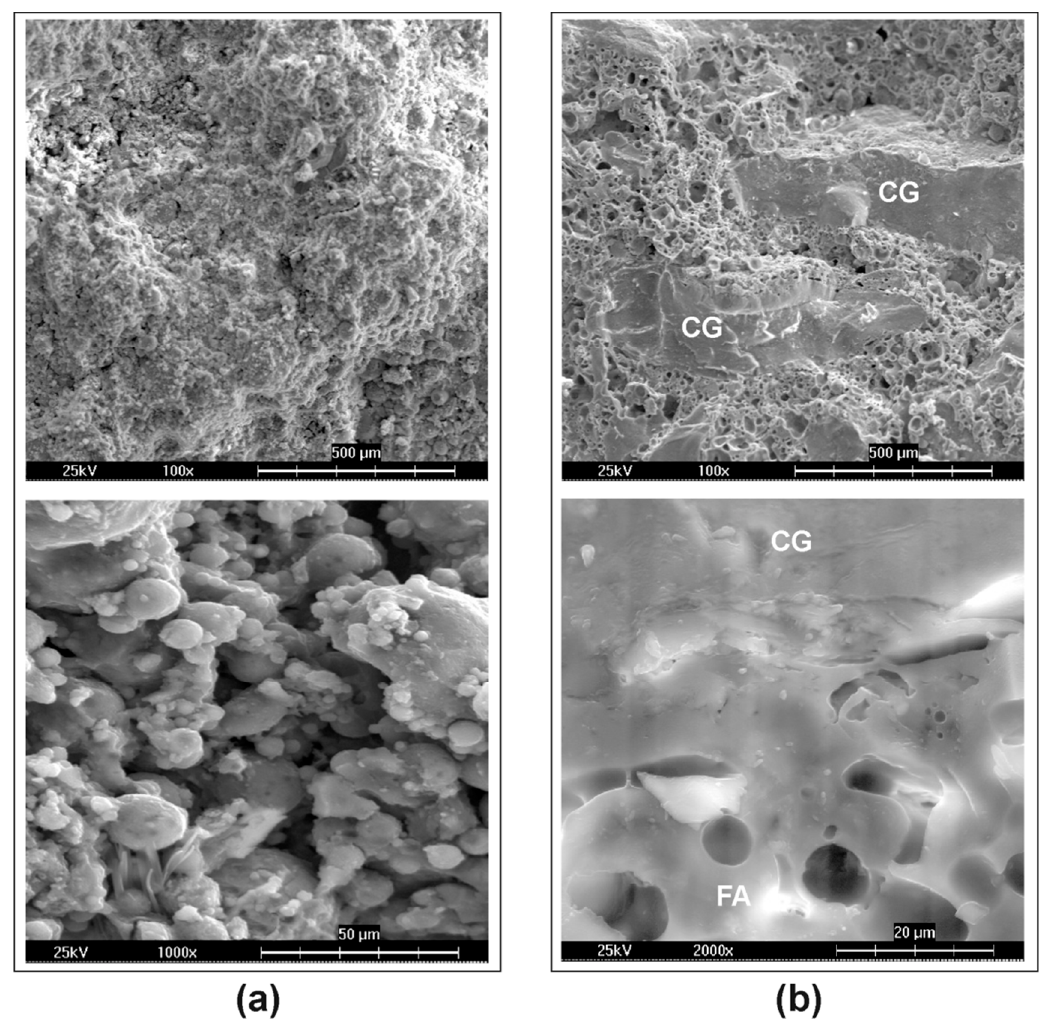
Figure 8. Micrographs of the FA mortar treated: ( a ) at room temperature; and ( b ) after heating to 1000 °C (CG = chamotte grain).